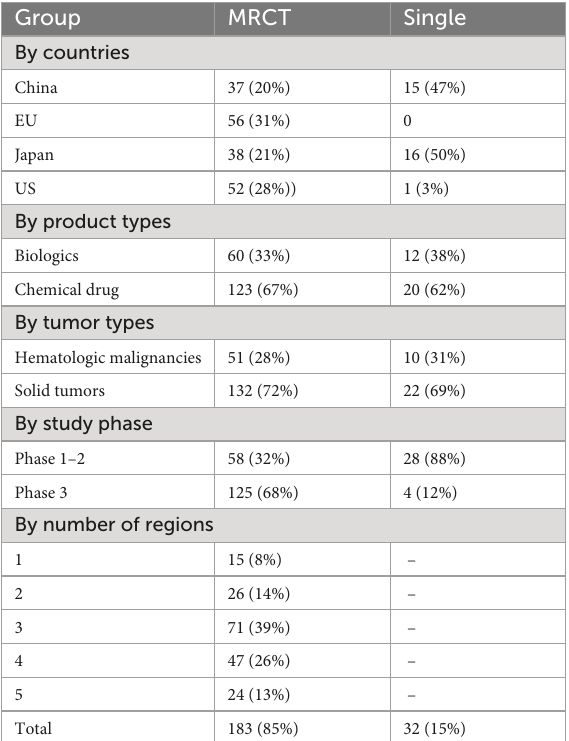
TABLE 5 Characteristics of pivotal trials.